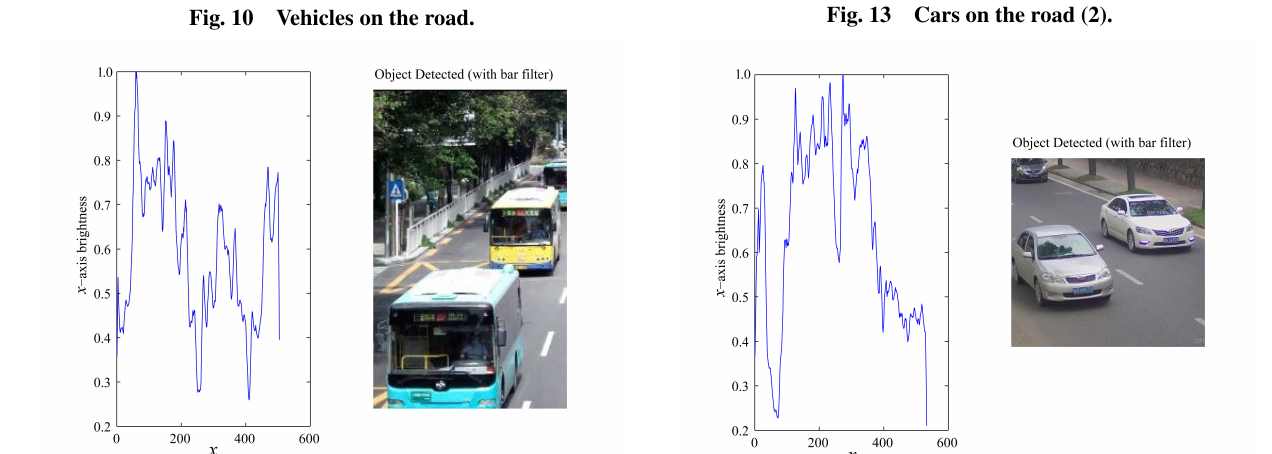
Fig. 10 Vehicles on the road.